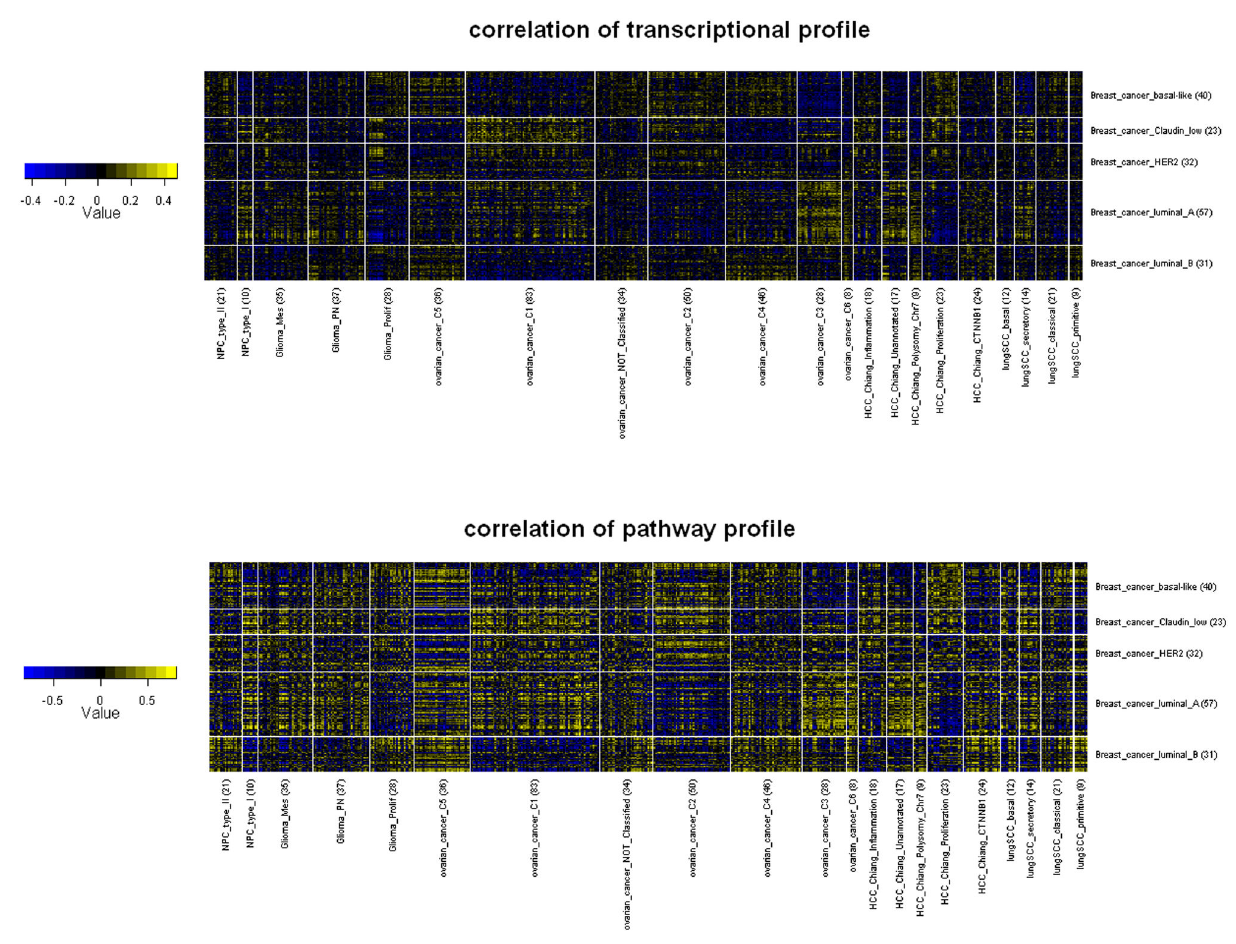
Figure 1. Comparison of breast cancer and other cancer. . Tumor samples were grouped by subtype. Yellow grids represented positive correlation while blue grids represented negative correlation. The number of samples per subtype was inside the brackets. doi: